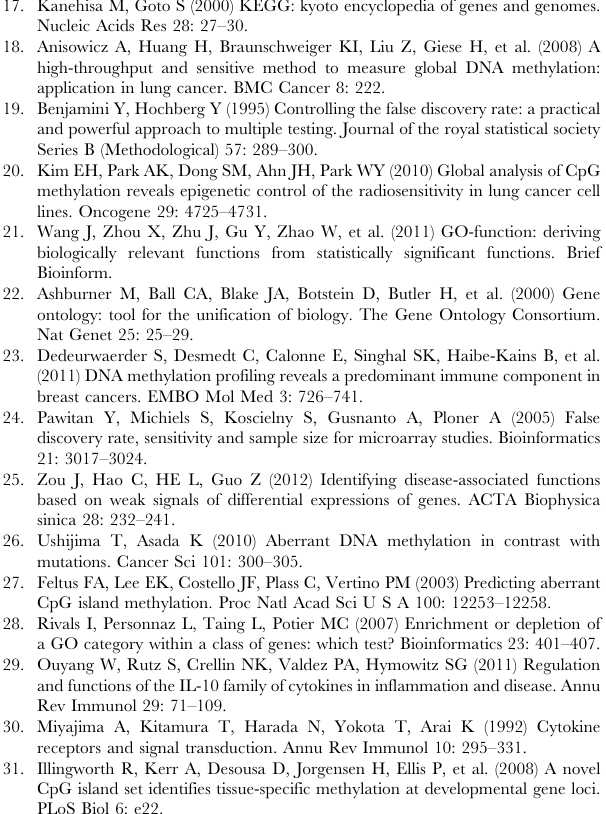
Figure S1 The POE scores between every two lists of the hypermethylated functions extracted for the four meth- ylation-based subtypes of colon cancer. Each row repre- sents the scores between the hypermethylated terms for one subtype and the hypermethylated terms for the other subtypes. The POE score 1 is shown in red and 0 is indicated in blue. The details of the four subtypes are described in [35]. Table S1 Terms that are consistently hypermethylated across different cancer types. This table shows the 117 GO terms that are consistently hypermethylated across different cancer types with the P values of enrichment for all of the cancer types.